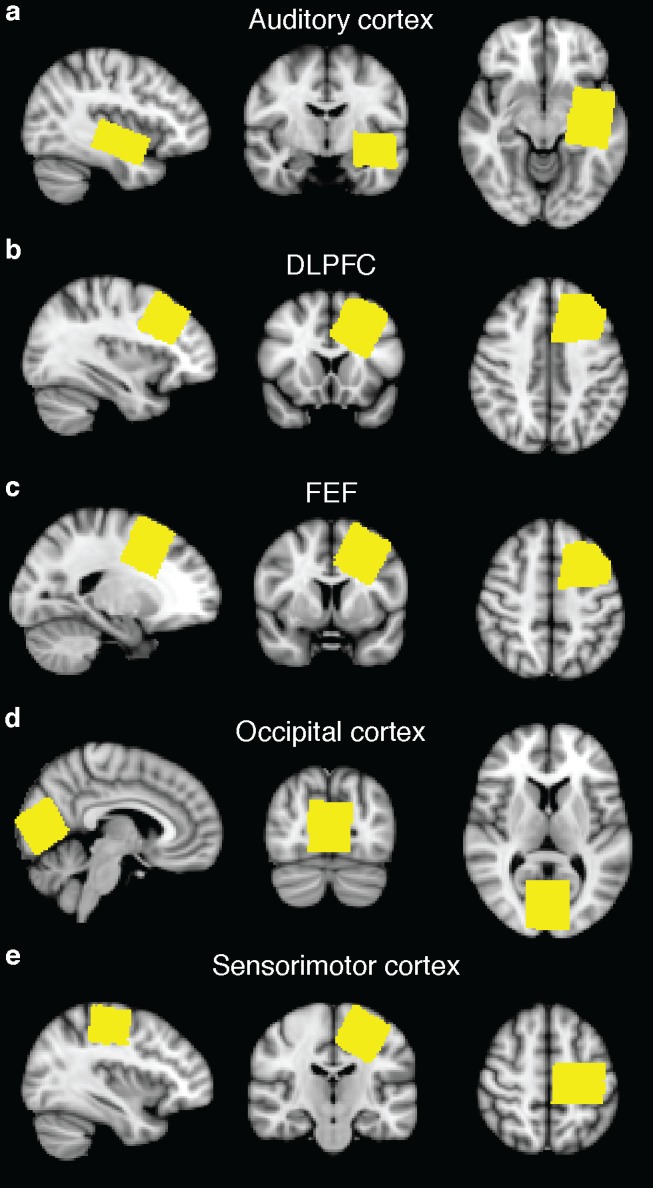
MRS voxel placement.MRS voxel mask images for one subject, transformed into standard space and overlaid on the MNI standard-space atlas, for all five locations: (a) auditory cortex; (b) dorsolateral prefrontal cortex; (c) frontal eye field; (d) occipital cortex; and (e) sensorimotor cortex.